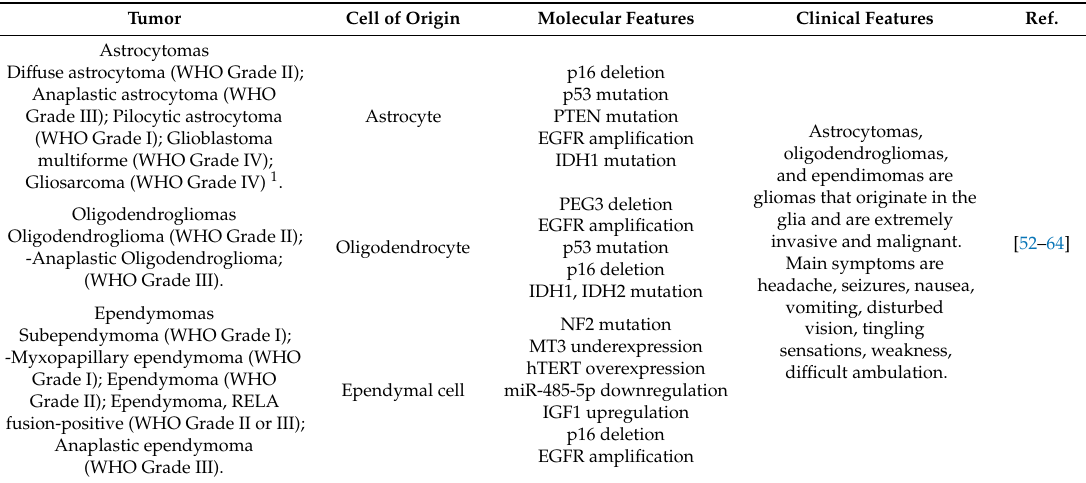
Table 1. Characteristics of the most common primary brain